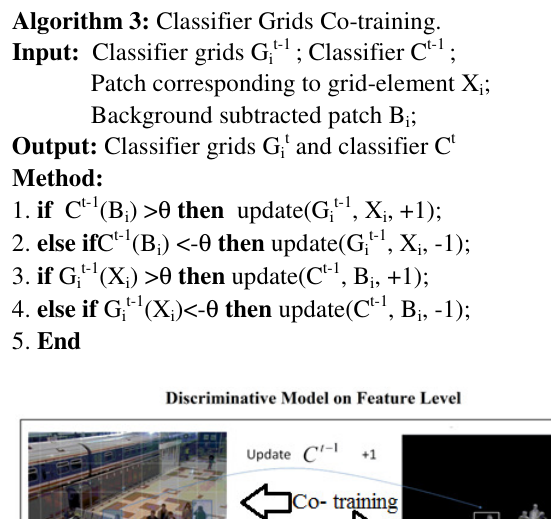
Algorithm 3: Classifier Grids Co-training.